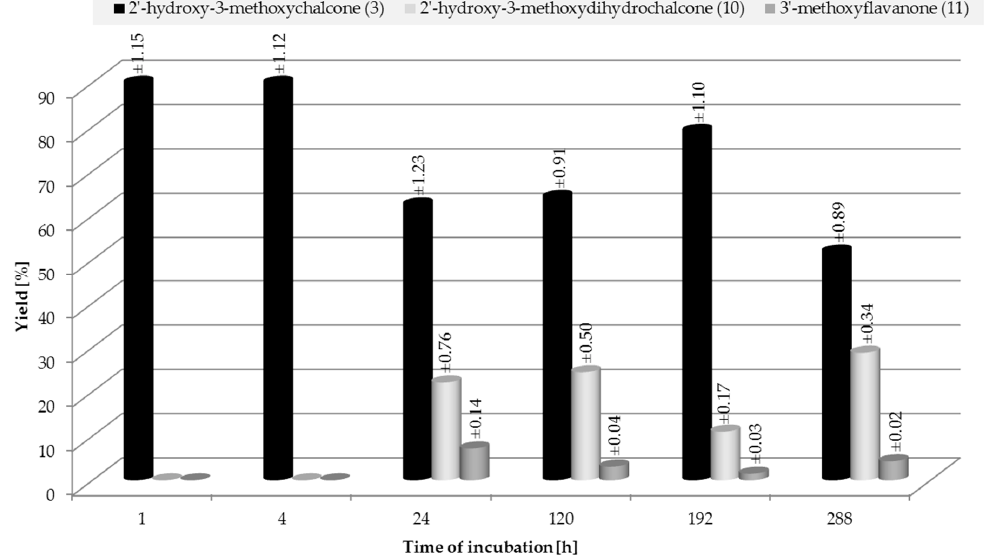
Figure 3. Biotransformation of 2 ′ -hydroxy-3-methoxychalcone ( 3 ) in S. maltophilia KB2 culture; the yields (%) of the products were determined by HPLC.